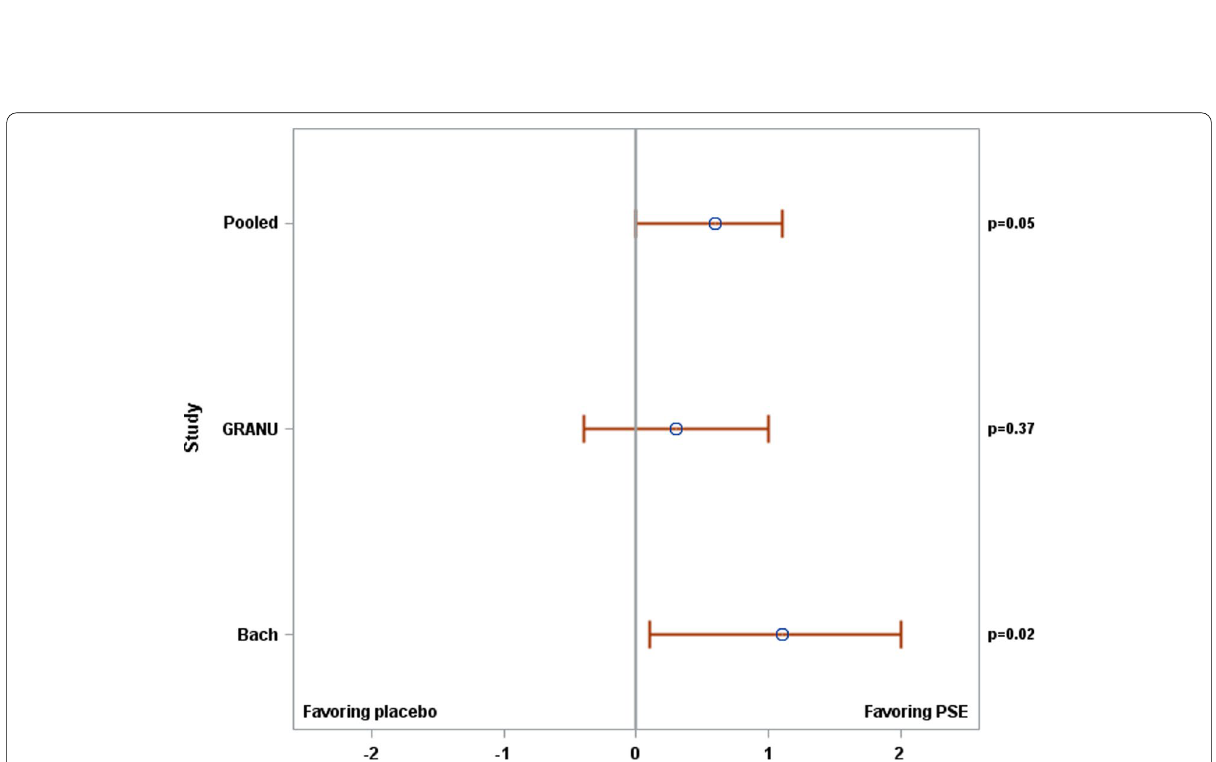
Fig. 4 Forest plot showing the mean difference (with 95% CI) between the treatments (placebo minus PSE) in IPSS change from baseline after 12 months of treatment; ITT set using LOCF. PSE pumpkin seed soft